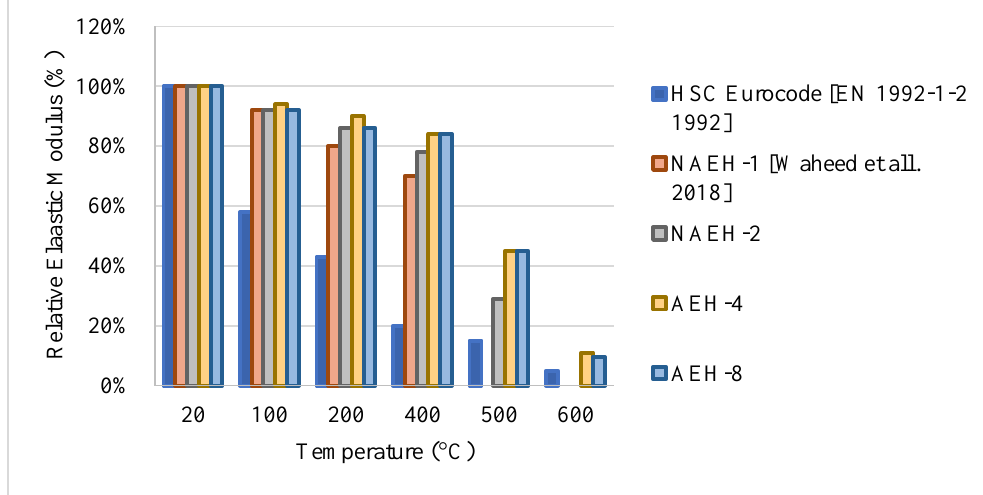
Figure 41. Relative Elastic modulus of different naturally cooled HSC mixes